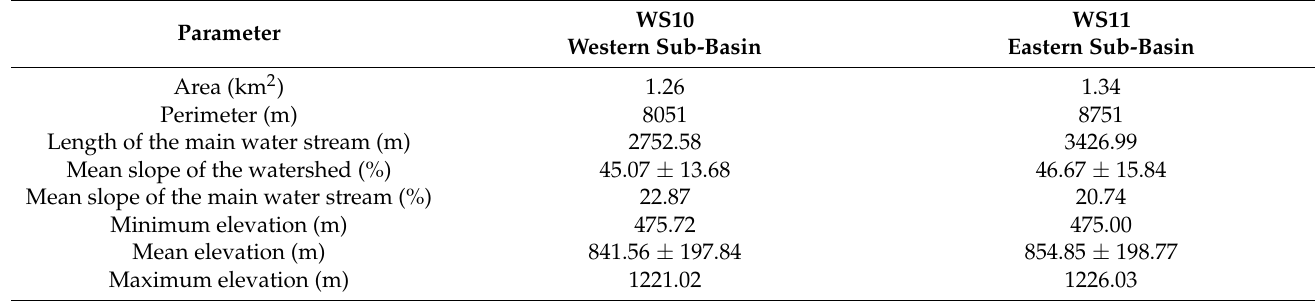
Table 1. Morphometric features of the Tinella sub-basins WS10 and